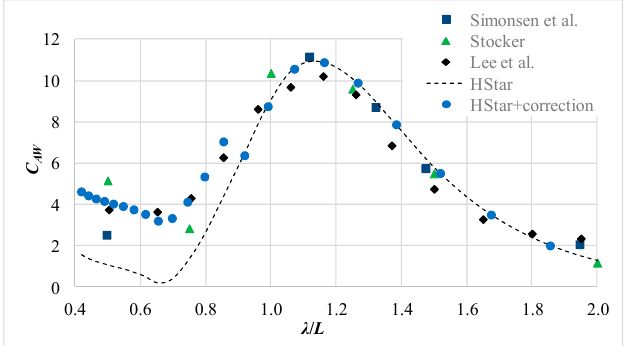
Figure 4. Comparison of the numerically obtained added resistance coefficient with available experimental data [36–38].